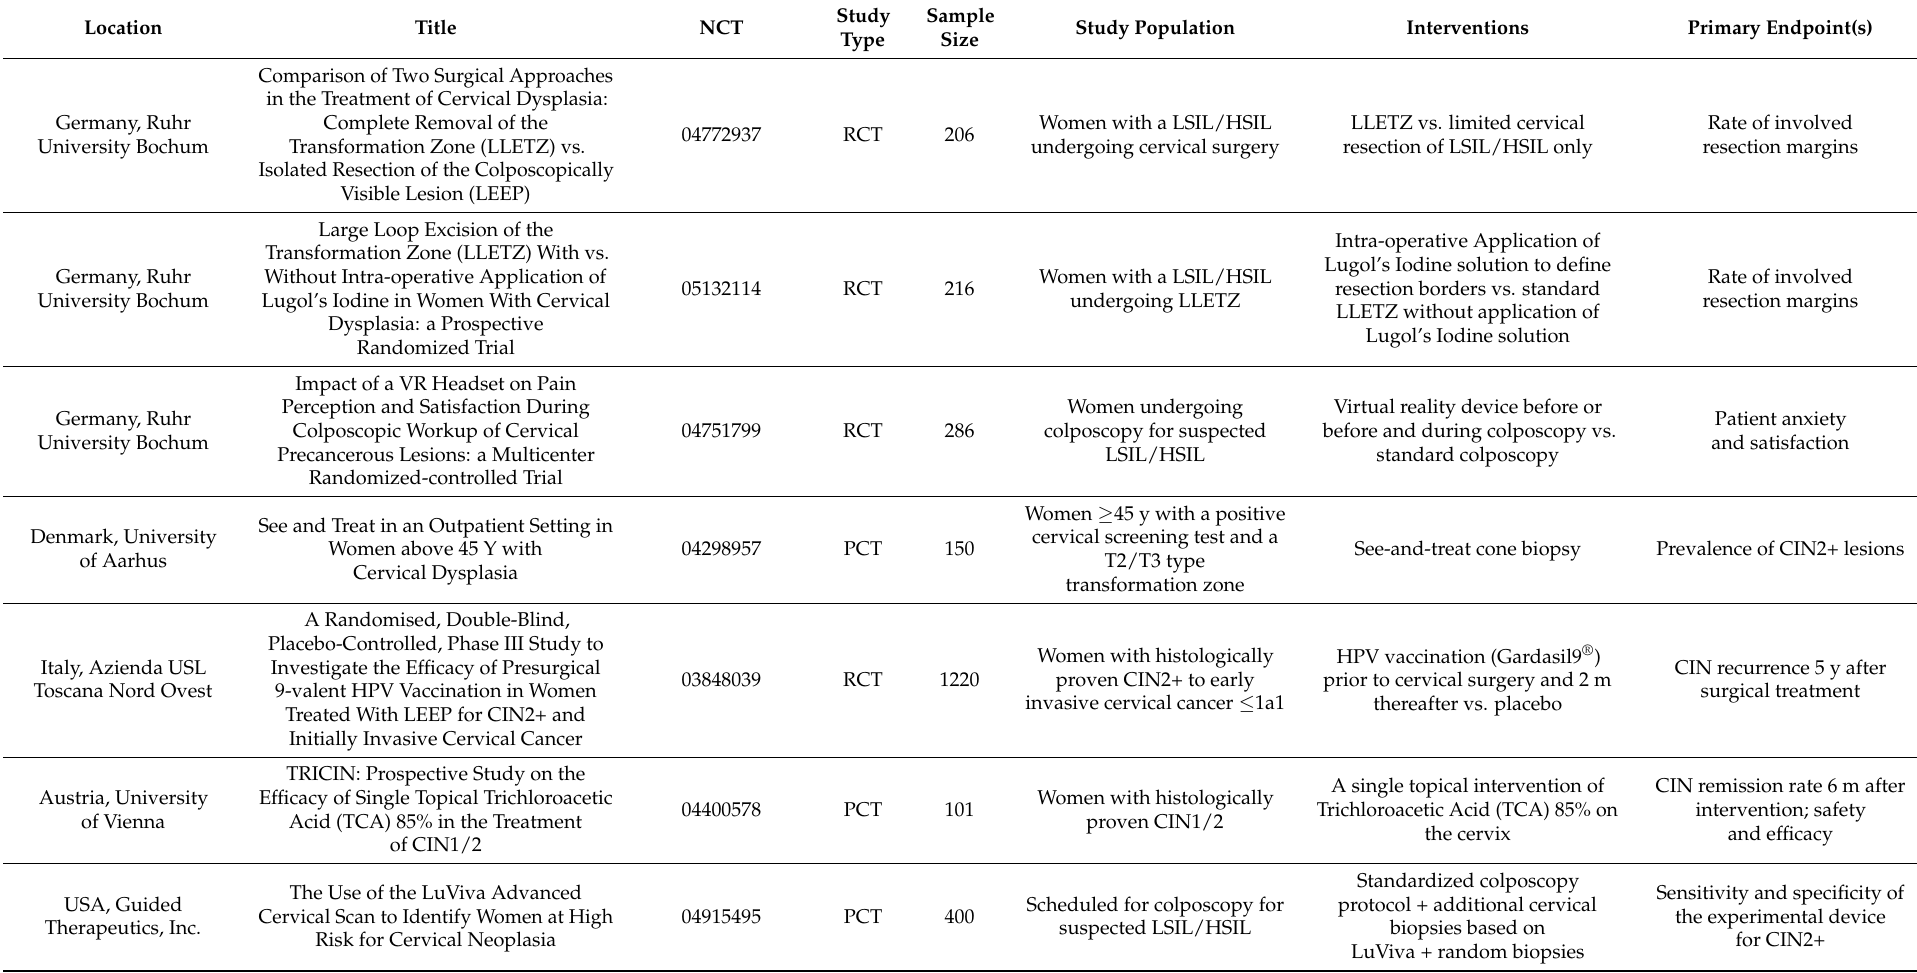
Table 3. Study characteristics of ongoing clinical trials listed at